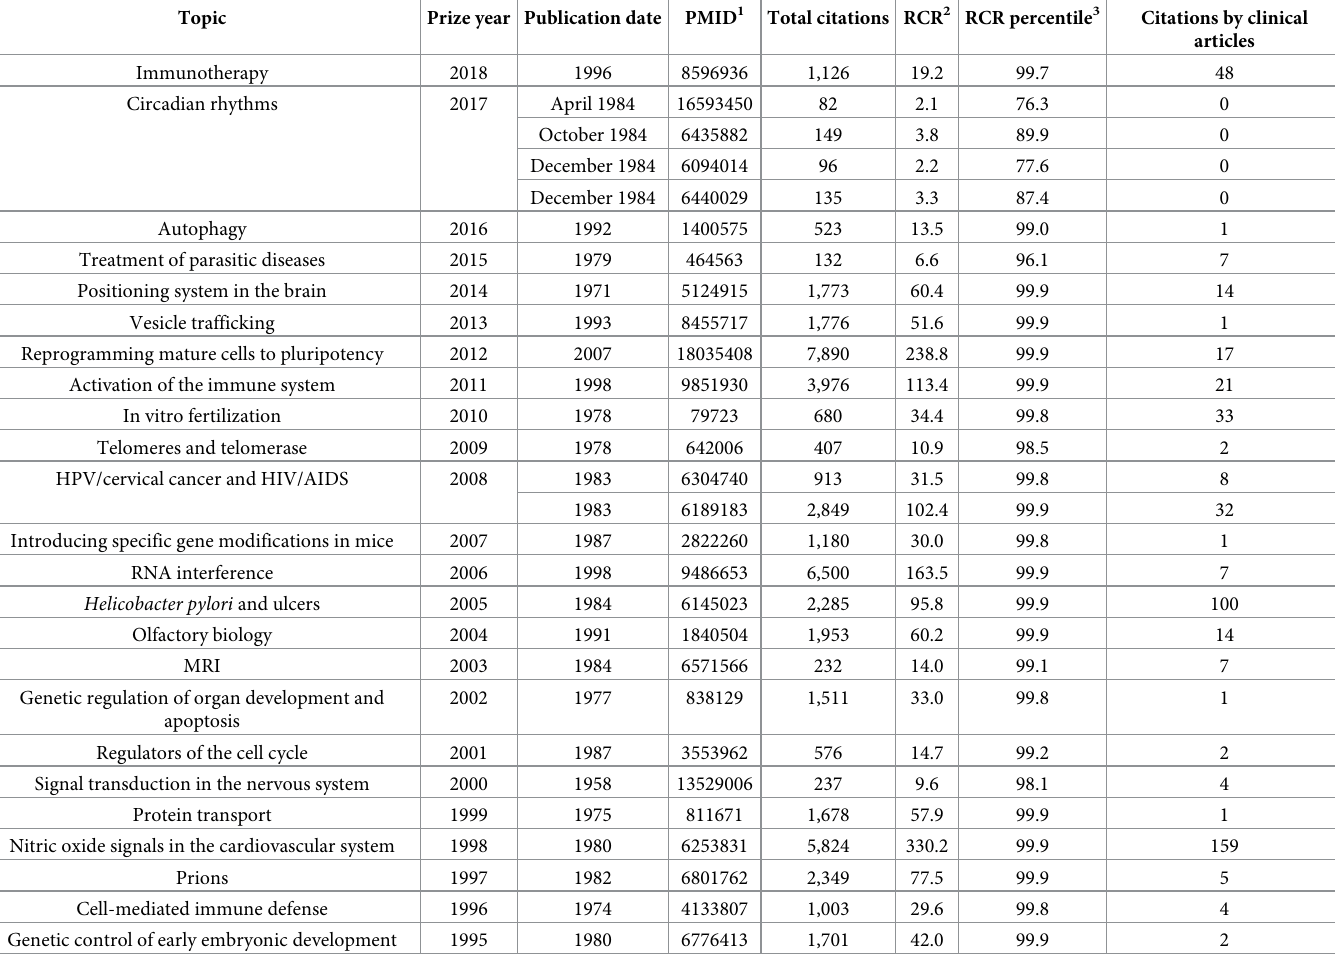
Table 1. Seminal publications leading to Nobel Prizes in Physiology or Medicine and their clinical citations.